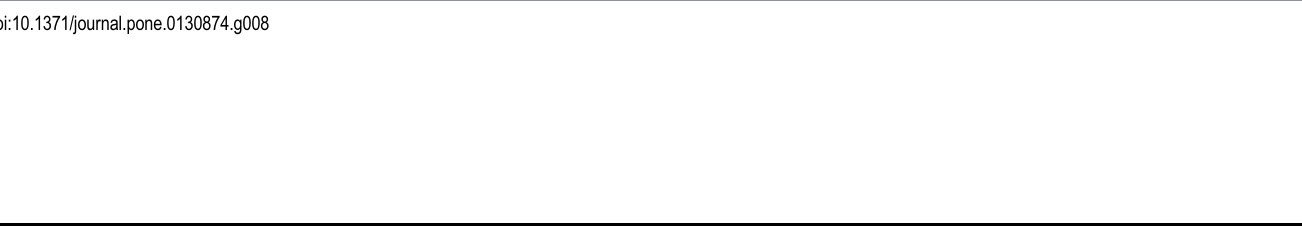
PLOS ONE | DOI:10.1371/journal.pone.0130874 June 18,